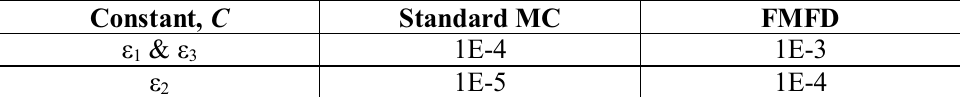
Table I. Constants for the convergence and stopping criteria of the m-PRUP